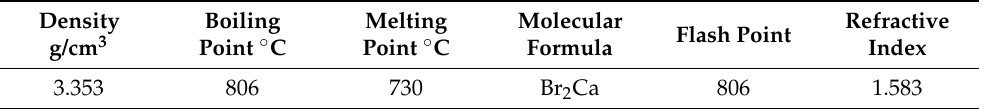
Table 5. Parameters of calcium bromide.